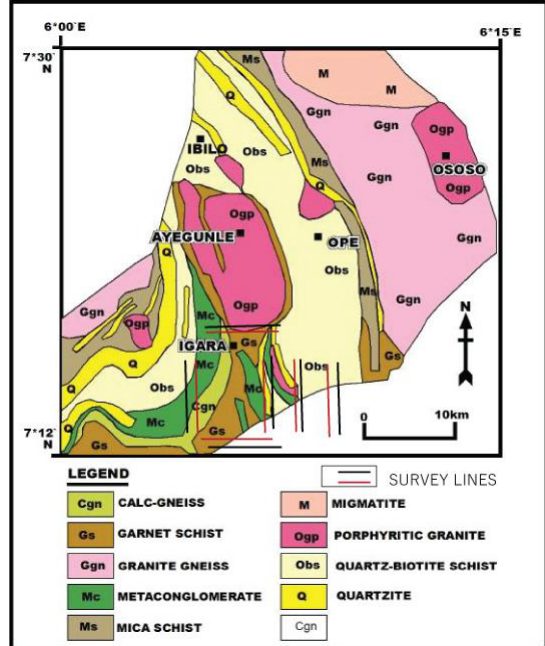
Figure 2 : Geological Map of the Study Area and